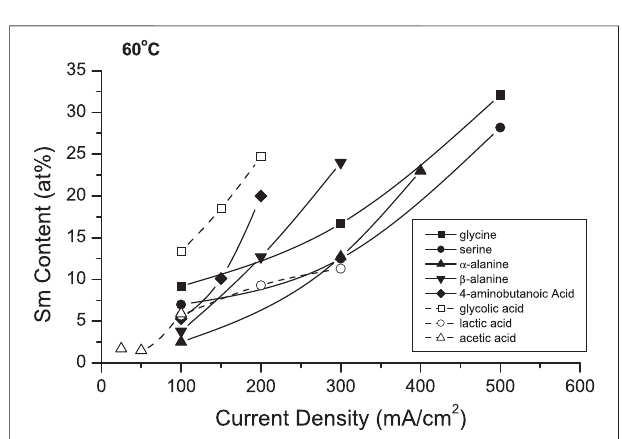
FIGURE9| Effect ofvarious complexesonsamariumdeposit contentat 60 ° C (pH (cid:2)